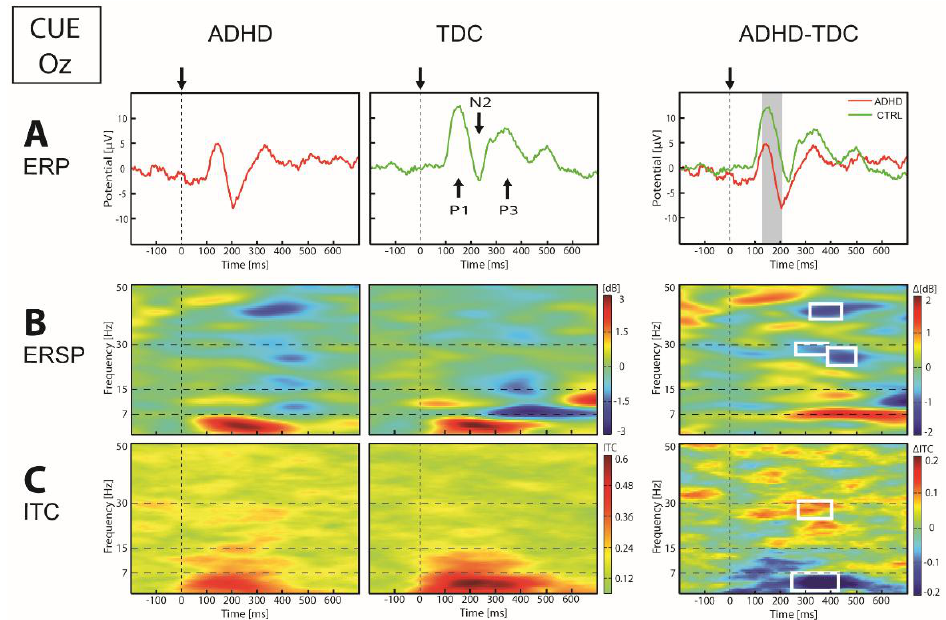
Figure 3. Event-related potentials (ERP) ( A ), event-related spectral perturbation (ERSP) ( B ) and inter-trial coherence (ITC) ( C ) in Oz electrode in response to Cue stimulus. On the ERP panel: arrows and vertical dotted lines indicate stimulus onset, vertical gray band indicates significance at p < 0.05. On the ERSP and ITC panel: vertical dotted lines indicate stimulus onset, horizontal dotted lines define frequency bands, and white square indicate significance at p < 0.05.